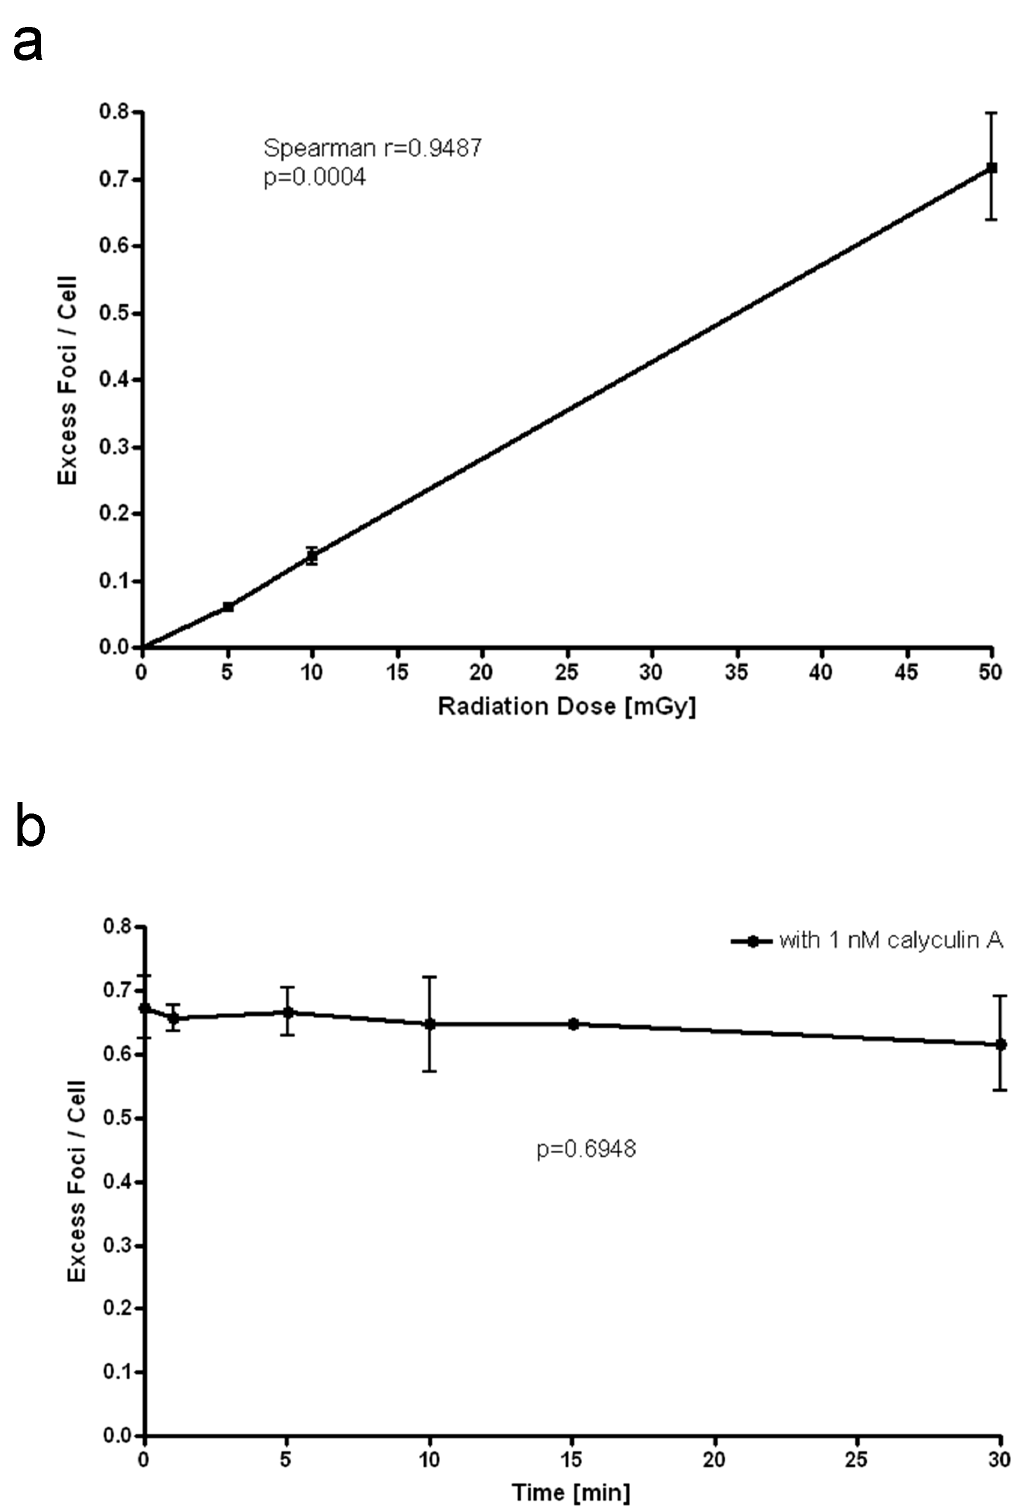
Figure 2. Validation of c -H2AX foci quantification. (a) illustrates the dose effect curve. Samples were irradiated with doses ranging from 5 to 50 mGy and were incubated for 5 minutes (n=3). (b) shows a time plot of foci in lymphocytes pre-treated with 1 nM Calyculin A after irradiation with 50 mGy (n=3). Means and standard deviations are presented. P , 0.05 was considered statistically significant.